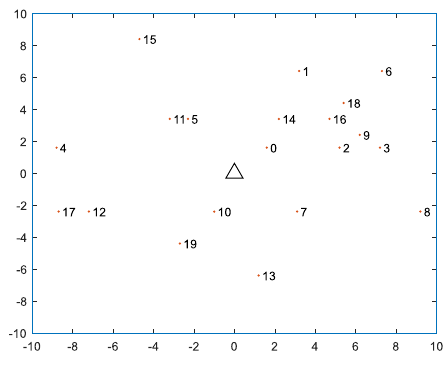
Figure 3. The topology for a 20-node wireless powered communication network.